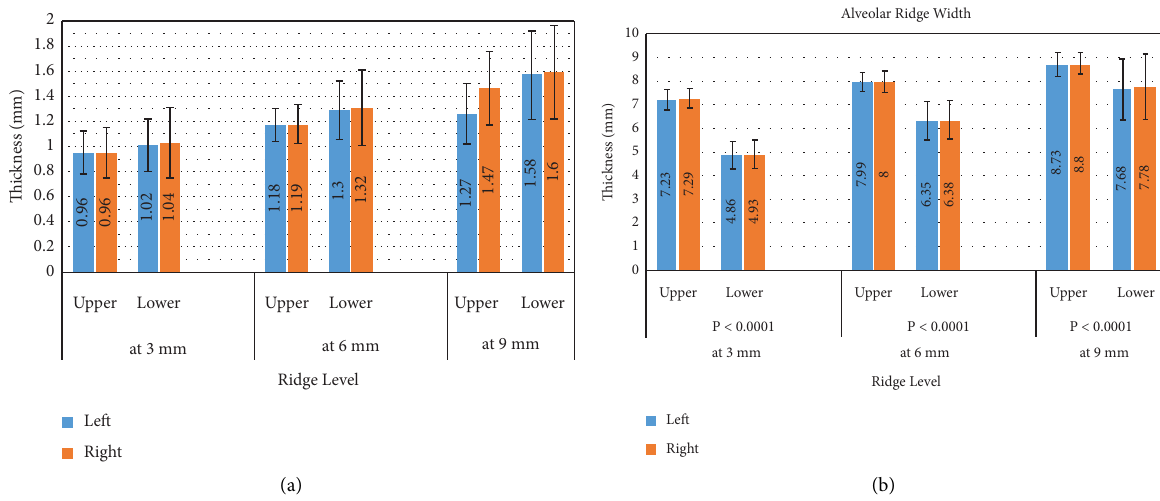
Figure 3: Bone width in millimeters of the upper and lower central incisors (both sides) at 3 levels (3mm, 6mm, and 9mm from the cementoenamel junction) ( n � 100 for each). Error bars represent the standard deviations. P values in X -axis represent the signifcance between the upper and lower measurements at the same level. (a) Facial cortical bone thickness; (b) alveolar bone width.